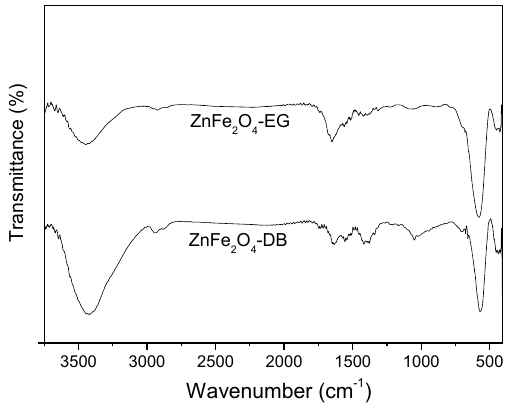
Figure 2. FTIR spectra of the samples prepared with different solvent diols.